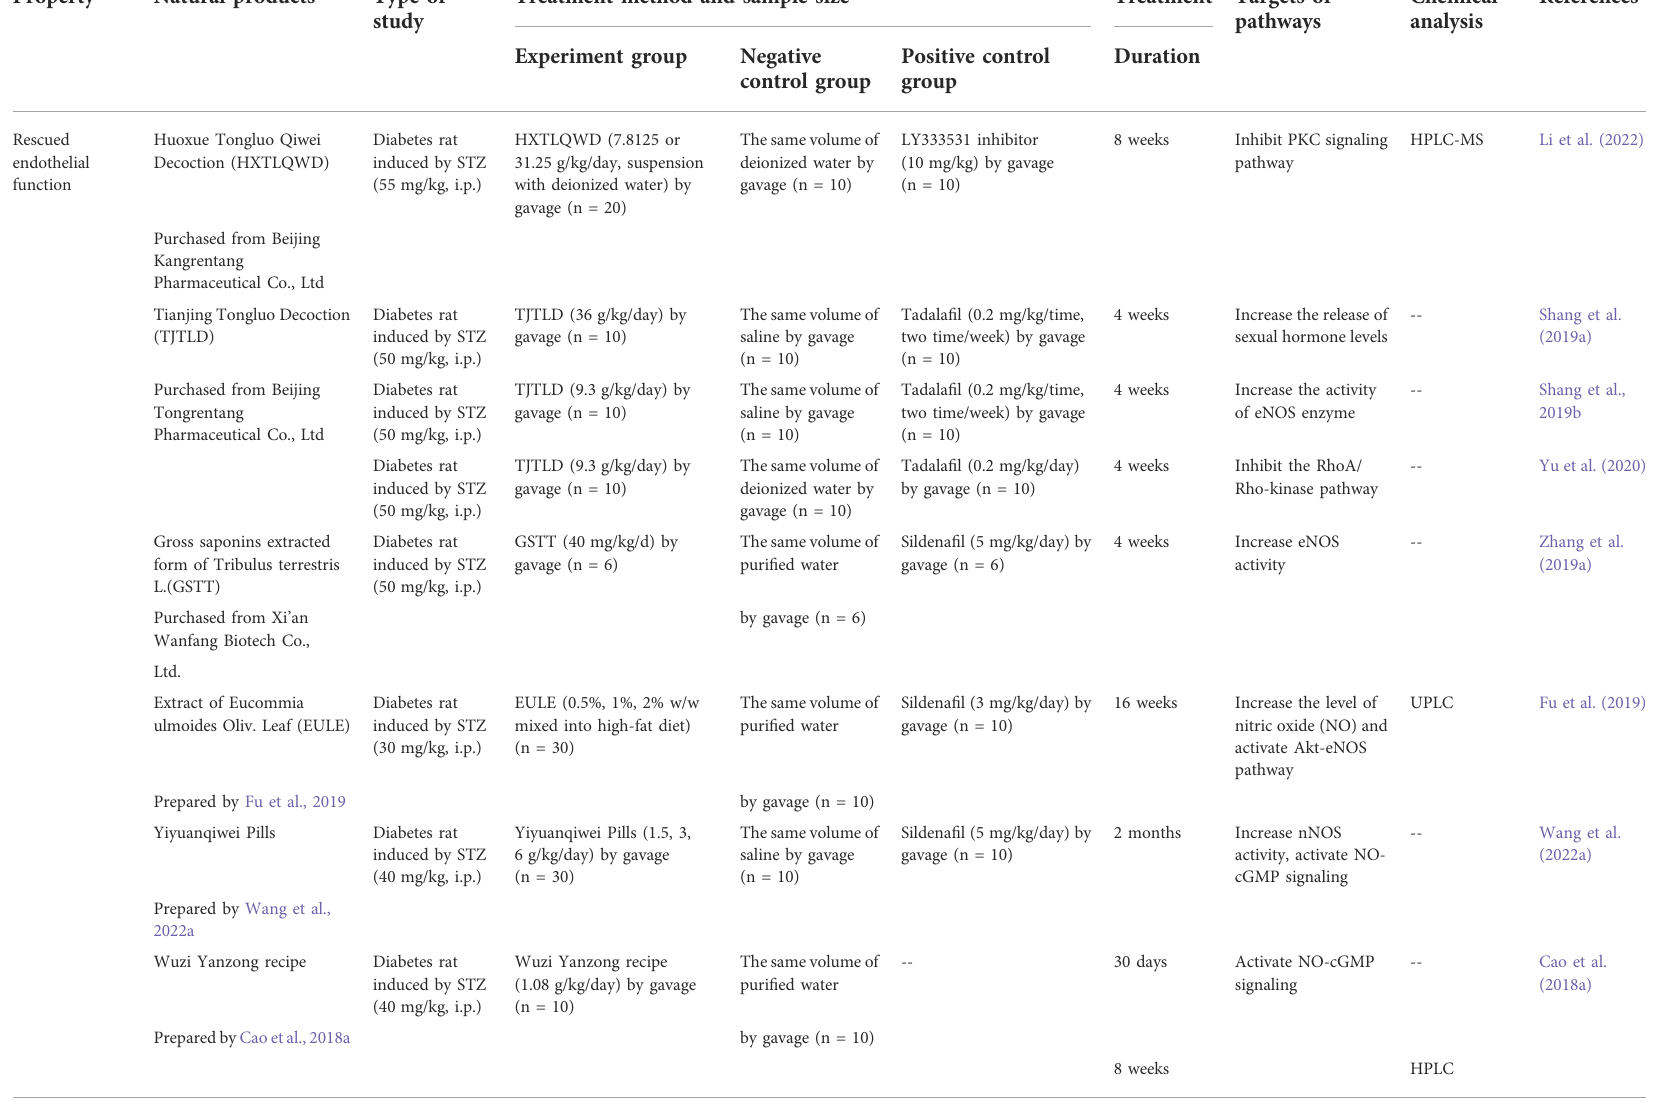
TABLE 2 The mechanisms by which Traditional Chinese medicine treat